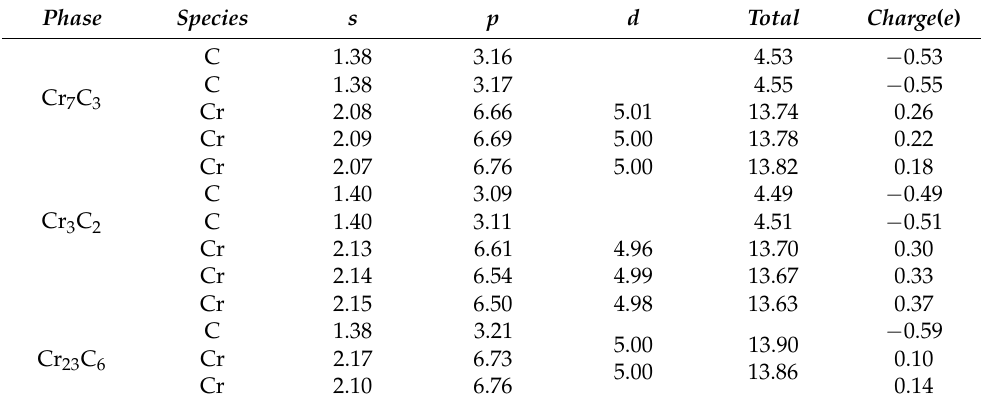
Table 3. Atomic orbit population of Cr 7 C 3 , Cr 3 C 2 and Cr 23 C 6 at zero pressure.